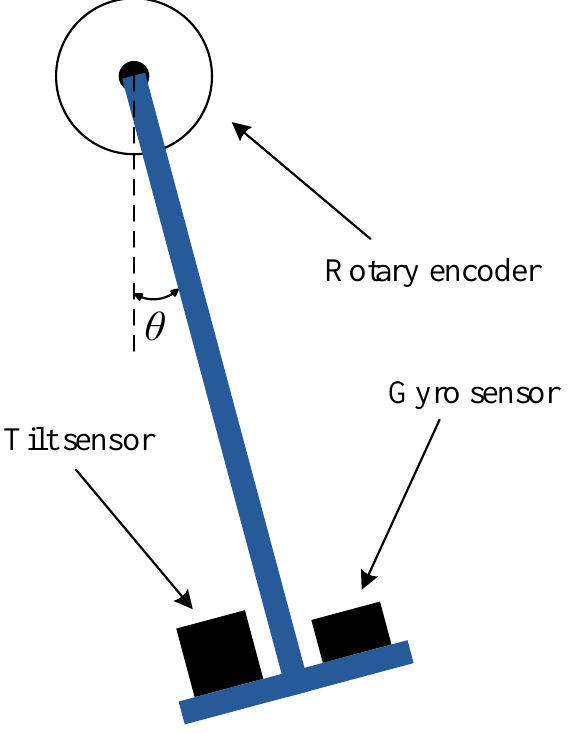
Figure 3. The encoder for recording the true orientation